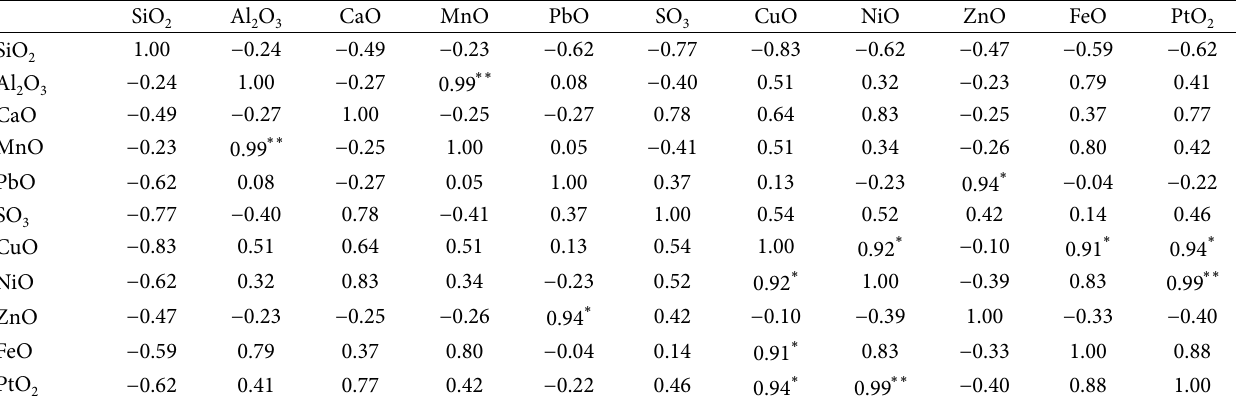
Table 3: Component correlation analysis.